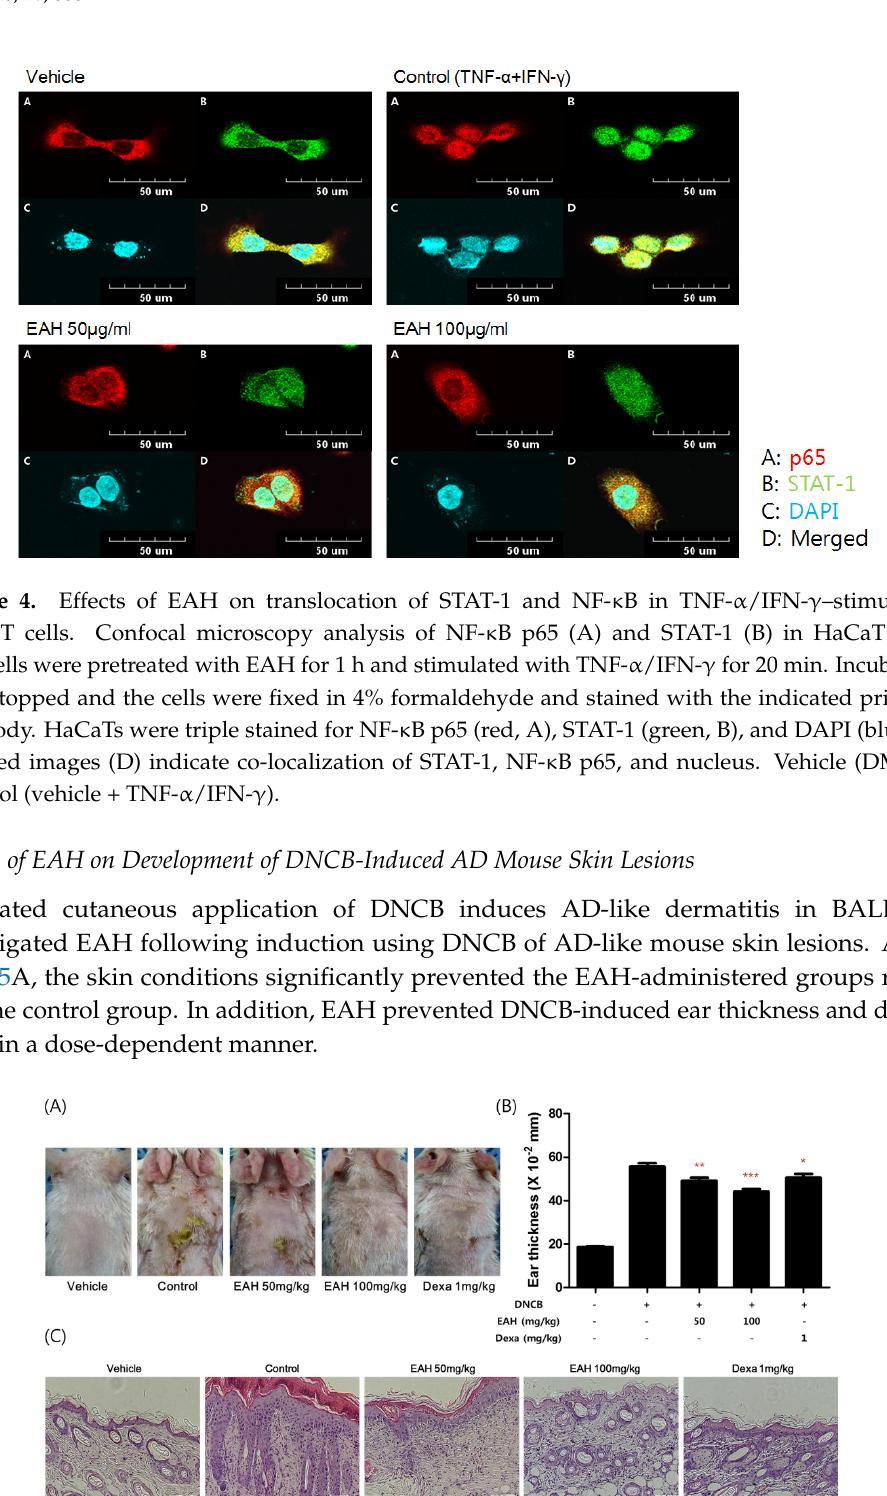
Figure 5. Effects of EAH on development of DNCB-induced AD mouse skin lesions. ( A ) Effects of EAH on clinical features of DNCB-induced AD skin lesions. ( B ) Ear thickness was measured by using